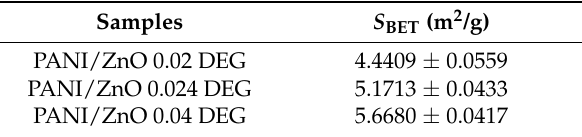
Table 4. Specific surface area ( S BET ) of PANI/ZnO